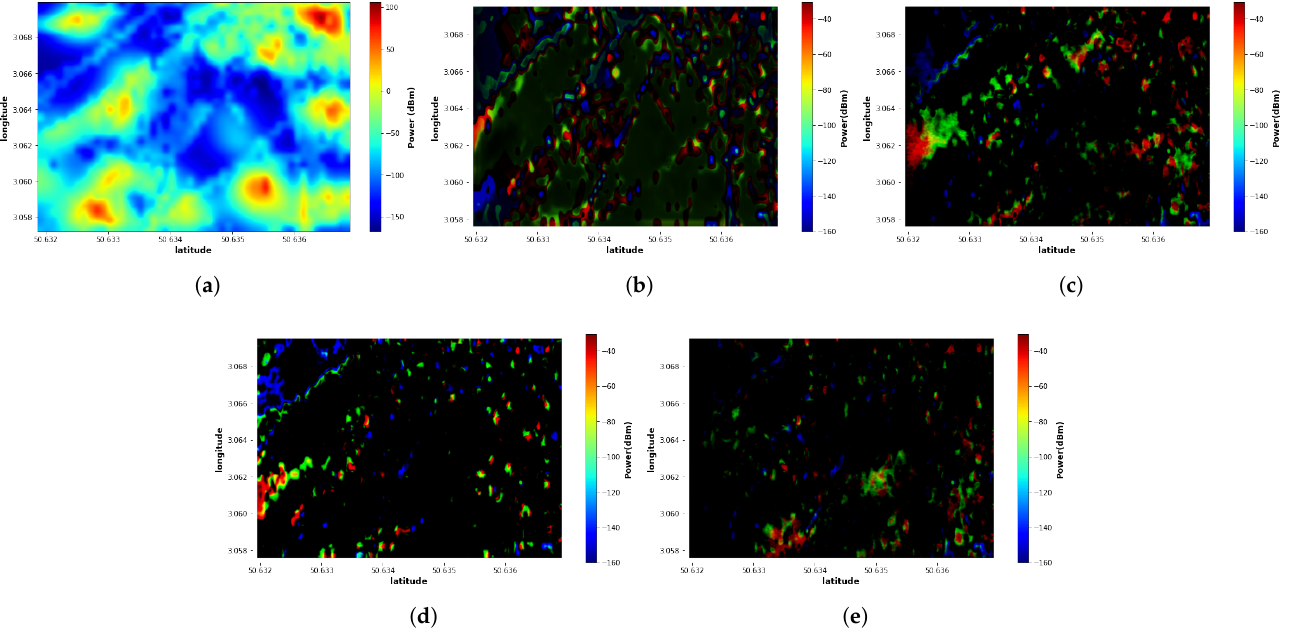
Figure 8. Error maps of the proposed EMGAN for different numbers of sensors and EME-Net model: ( a ) Kriging 50 sensors; ( b ) EME-Net 50 sensors; ( c ) EMGAN 15 sensors; ( d ) EMGAN 30 sensors; ( e ) EMGAN 50